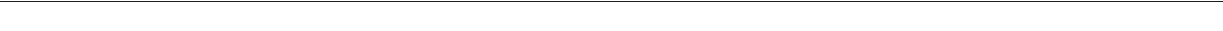
Fig. 1 Two-dimensional HPLC fractionation of neutral N-glycans from Diro fi laria immitis . For the fi rst dimension, the pyridylaminated N-glycans were separated by HIAX (calibrated with a set of glycans from white beans, e.g. Man 3 GlcNAc 2 Xyl 1 and Man 6-9 GlcNAc 2 ) and detected by fl uorescence; shown in the top panel is the overall pro fi le of one female N-glycome, whereas the zoom shows more detail of a second preparation. The male N-glycome had a similar pro fi le (see also the MALDI-TOF – MS and 1D-RP-amide HPLC data in Supplementary Figures 2 and 4). Indicated are pooled regions whose second- dimension RP-amide HPLC pro fi les are shown in a – j , whereby chromatograms a – c , i and j are from the male glycome and d – h from a female preparation (note that subfraction j contains Man 8 GlcNAc 2 , but not Man 7 GlcNAc 2 isomers as present in the subfractions d , e and i of overlapping retention time). The RP-amide chromatograms, calibrated in terms of glucose units (g.u.), are annotated with selected glycan structures according to the Symbol Nomenclature for Glycans (see also grey inset; mannose is depicted by green circles, GalNAc/GlcNAc by yellow or blue squares, fucose by red triangles and phosphorylcholine by PC, whereas the angle of the GlcNAc-Man bond for tri-/tetra-antennary structures is indicative of either a 2-, 4- or 6-linkage 70 ). The m / z for the protonated ions as detected by MALDI-TOF – MS are also given with the depicted structures based on conclusions derived from elution time, chemical and/or enzymatic digestion and MS/MS data of which selected examples are shown in Figs. 2 – 4 and Supplementary Figures 5 – 9. The light green, pink and blue boxes highlight isomers of m / z 1744, 1890 and 1947 differing in the positions of antennal fucose and HexNAc residues. Based on integrated fl uorescence intensity, the HIAX peaks eluting later than 22 mins are estimated to account for 8% of the total N-glycome, of which half (i.e. 4% of the total) are larger non-oligomannosidic structures of over 1800 Da with novel and/or multiple